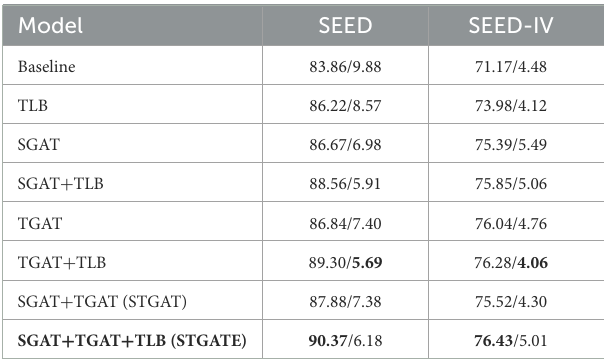
TABLE 3 Performance of our proposed modules on the SEED and SEED-IV